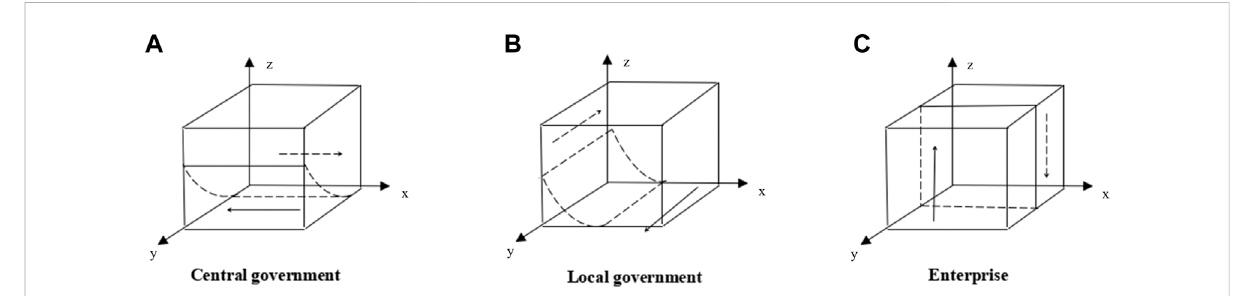
FIGURE 2 Phase diagram of the central government, local governments, and enterprises. Note: x denotes the central government chooses the “ strict supervision ” strategy, y denotes the local governments choose the “ implementation of low-carbon management ” strategy, and z denotes the enterprises choose the “ pulverization ”